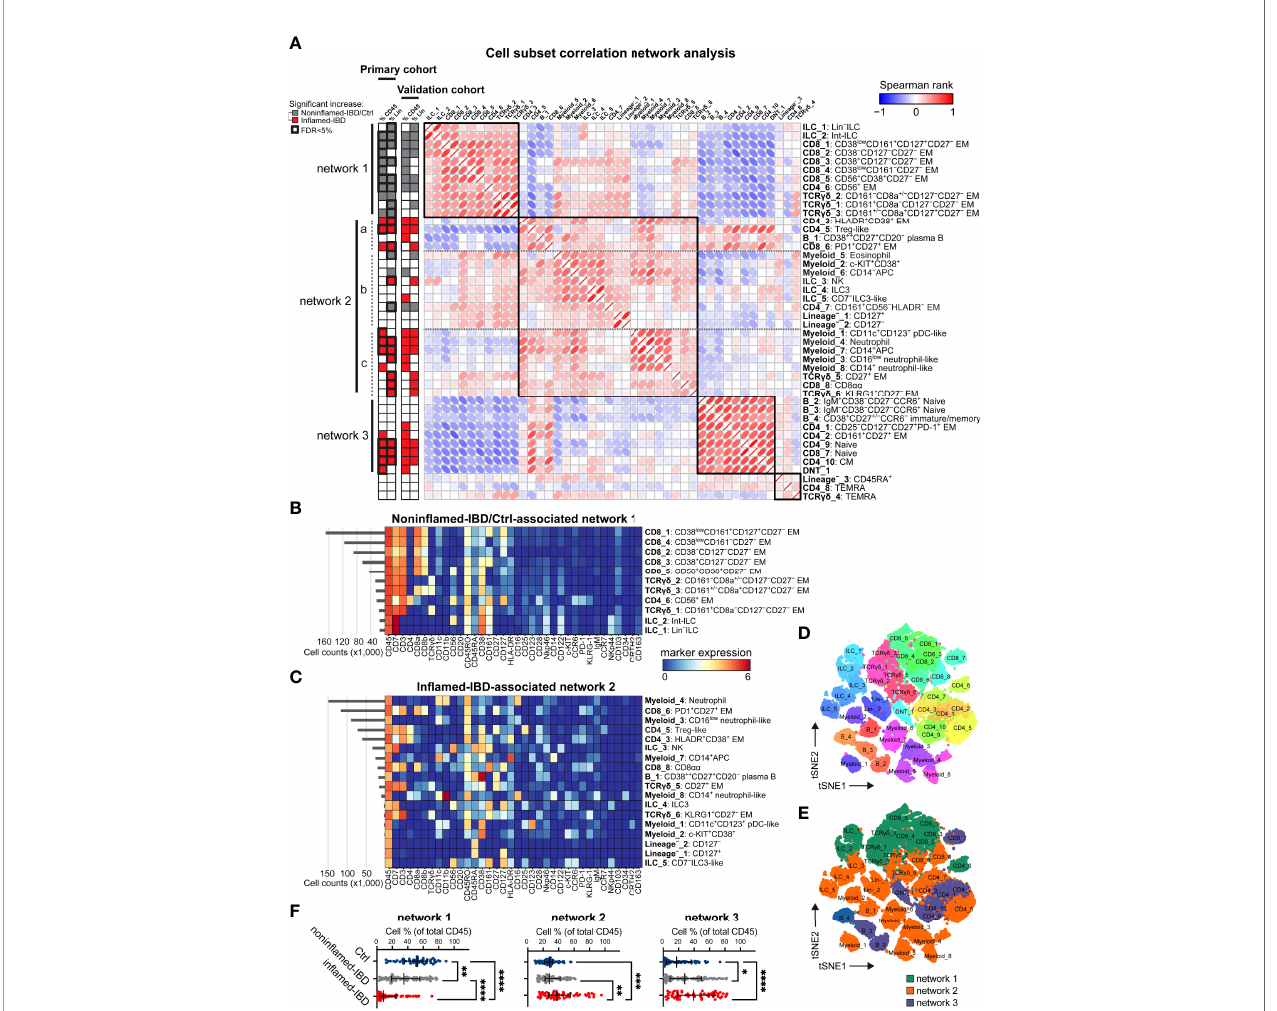
FIGURE 3 | Integrated immune system analysis identi fi es IBD-associated cellular networks. (A) Network representation of correlations (Spearman rank) between 44 immune subsets. Hierarchical clustering of correlations indicated by four black squares. Statistics bar (left panel) indicating signi fi cant (p<0.05) differences in cell frequencies comparing in fl amed-IBD (in red) samples with nonin fl amed-IBD/control samples (in grey) as determined with independent t-tests strati fi ed for the primary and the validation cohort. False discovery rate <5% highlighted with bold outline for the primary cohort. Heatmaps showing maker expressions of relevant cell subsets from (B) network 1 and (C) network 2 as de fi ned in panel (A) t-SNE maps of immune subsets (each downsampled to 1,000 cells) from the three networks and colored for (D) immune subset and (E) corresponding network. (F) Graphs showing the collective cell subset frequencies (as % of total CD45 + cells) of network 1, network 2 and network 3, for 53 control, 76 nonin fl amed-IBD and 59 in fl amed-IBD intestinal samples from the primary and the validation cohorts combined. Bars indicate the median with interquartile range. *p ≤ 0.05, **p ≤ 0.01, ***p ≤ 0.001, ****p ≤ 0.0001, Kruskal Wallis test for multiple